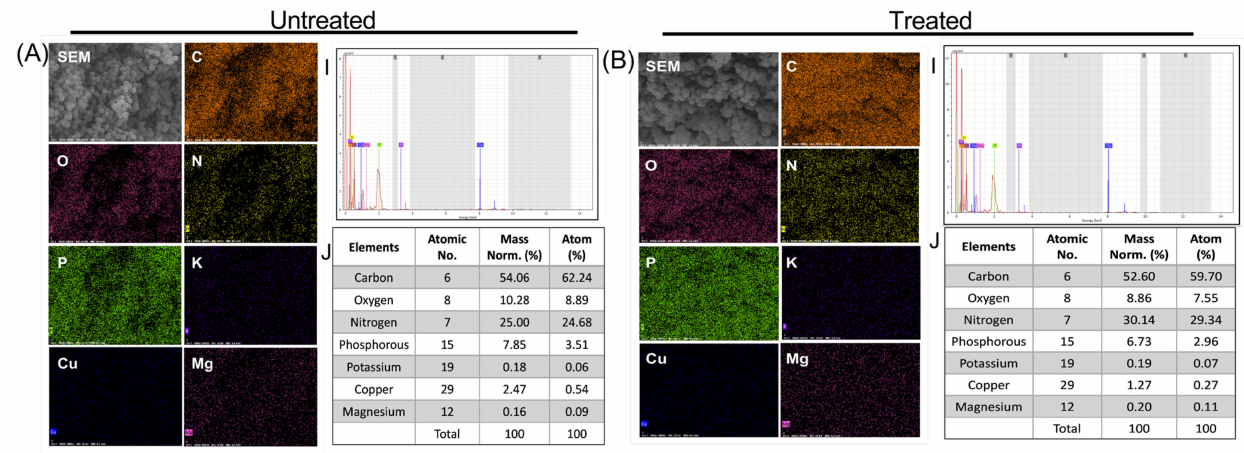
Figure 9. EDS elemental mapping displayed the distribution of elements in the PG-NOW untreated ( A ) and treated samples ( B ) of the S. aureus strain, which shows the SEM image of the bacterial structure together with carbon (C), oxygen (O), nitrogen (N), phosphorous (P), potassium (K), copper (Cu), and magnesium (Mg) and their spectra with mass